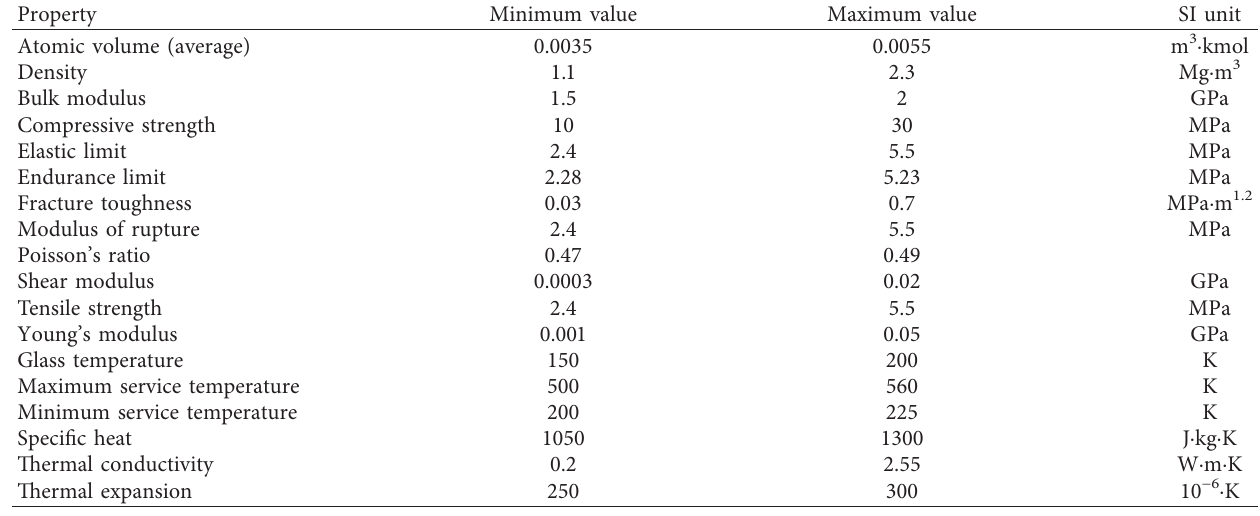
Table 1: Silicone rubber specifications.